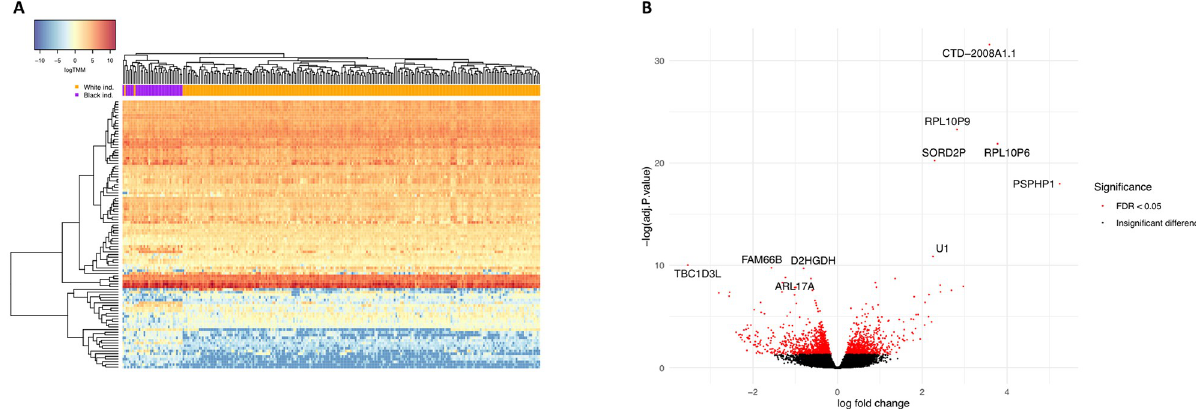
Fig 1. DEGs between Black and White individuals in non-sun-exposed skin. (A) Expression heatmap of the top 100 DEGs in 257 non-sun-exposed skin tissue samples, showing the result of a two-way unsupervised hierarchical clustering. Each row represents a DEG and each column represents a sample. The order of genes and samples was determined in an unsupervised manner, based on similarities in expression profiles, and is detailed in S3 Table. Samples are color coded according to their reported race. Expression values are presented in log(TMM), scaled according to the color key in the top left corner. (B) Volcano plot depicting the magnitude and significance of expression differences at the single gene level. For each gene expressed in non-sun-exposed skin, the log 2 fold change of normalized expression between Black and White individuals is shown on the X axis, and the negative log 10 of its FDR-adjusted P value is shown on the Y axis. Positive X values represent upregulation in Black individuals and negative X values represent downregulation. Significant DEGs are in red and the symbols of the 10 most significant ones are noted. DEG, differentially expressed gene.